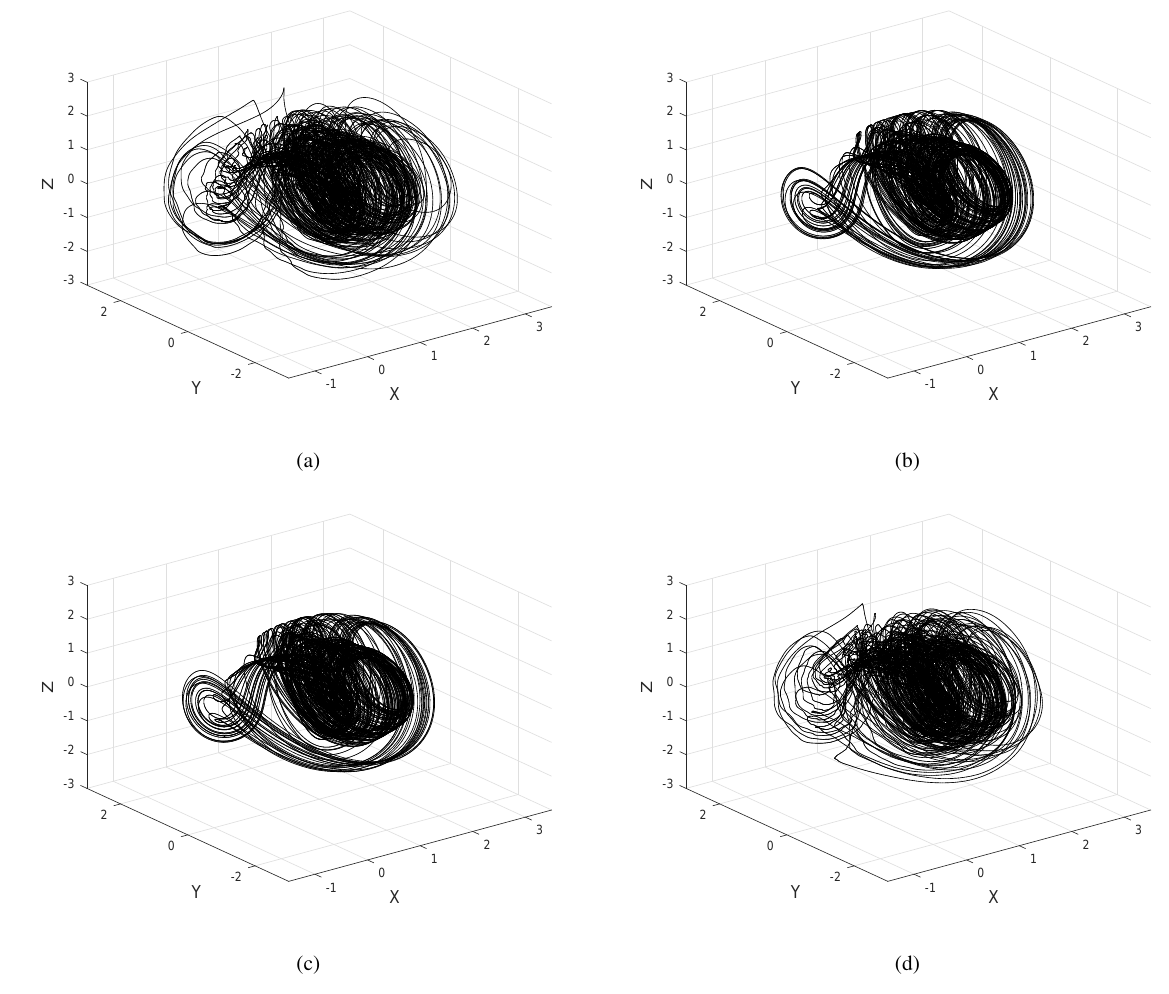
Figure 3. A 3-D view of the attractor of (a) coupled model, (b) uncoupled model, (c) 1st order parametrization, and (d) 2nd order parametriza- tion. For case τ = 5, the Lorenz 63 model acts as a fast forcing on the Lorenz 84